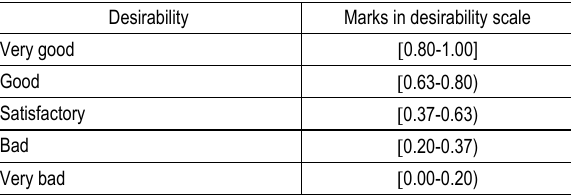
Table 1. Evaluation scale of Hurrington function desirability